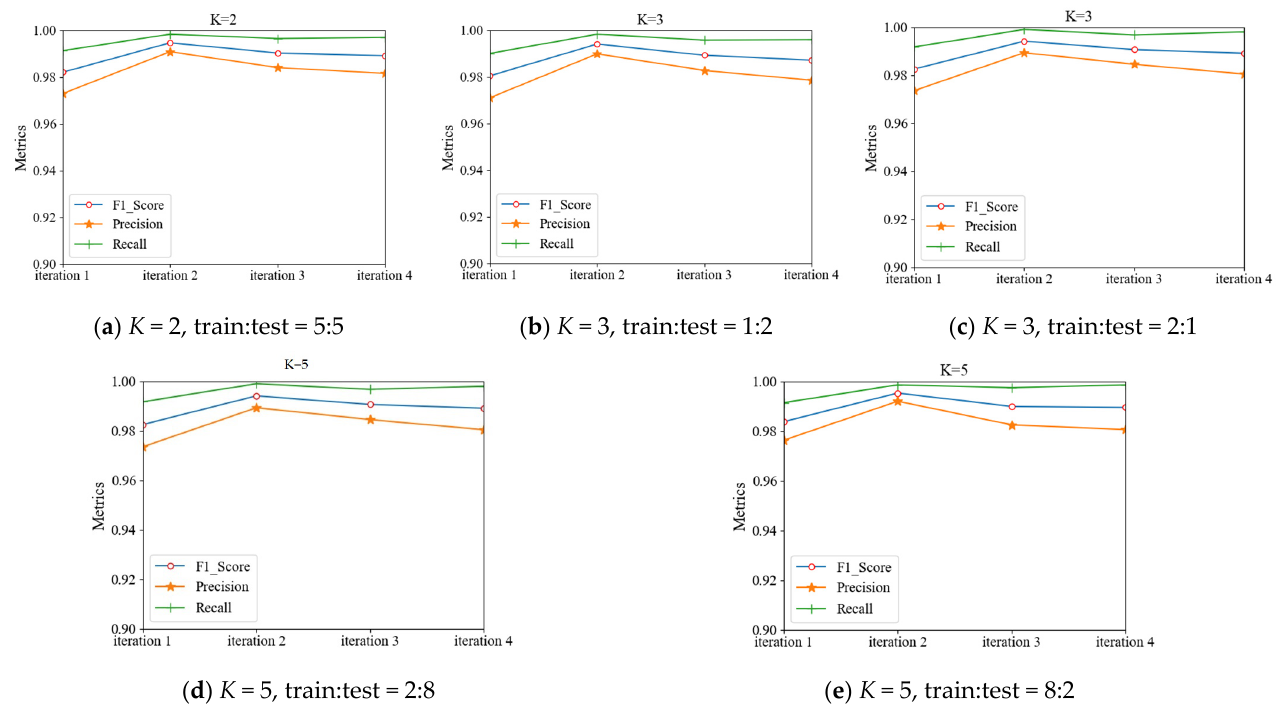
Figure 7. The iteration metrics of our model: ( a – e ) the metrics under the K-fold cross-validations and the percentage of divisions, which were tested on the edX dataset with four iterations. Blue: F 1; orange: Precision ; green: Recall .